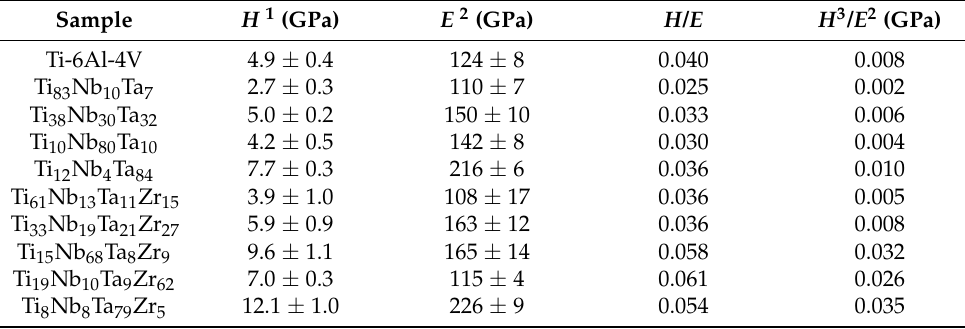
Table 2. Mechanical properties of TiNbTa and TiNbTaZr films.